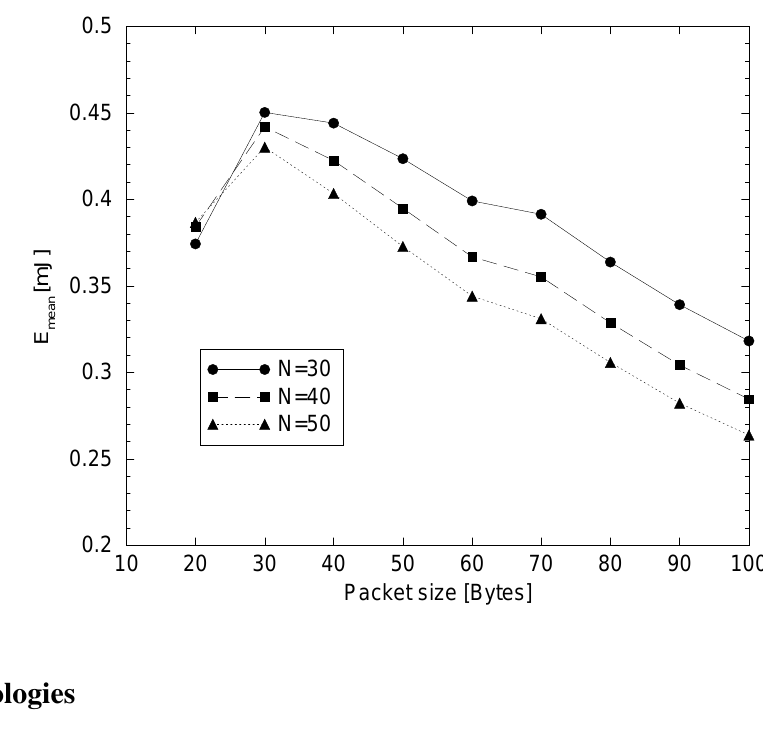
Figure 13. The mean energy spent by an 802.15.4 node working in non beacon-enabled mode, belonging to a network of N nodes organised in a star